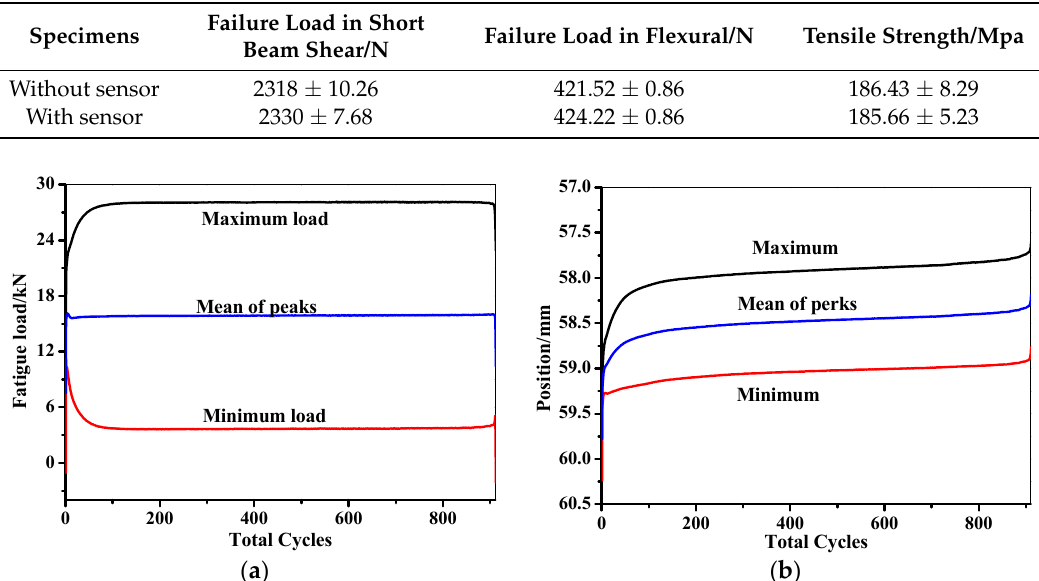
Figure 8. Resistance–loading time in the tensile tests. ( a ) Longitudinal resistance vs. loading strain. ( b ) Transverse resistance vs. loading strain. ( b ) Transverse resistance vs. loading strain. Table 2. The mechanical performance of the composites laminates before and after embedding the multi-walled carbon nanotube (MWCNT) sensors in different mechanical tests.